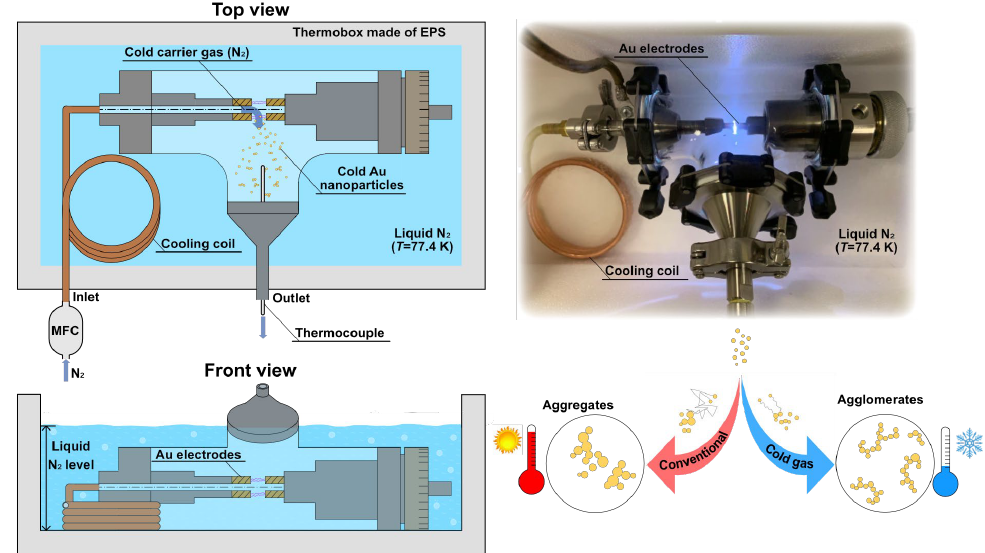
Figure 1. Image of the experimental setup for the synthesis of nano particles in cold gases (N₂, Ar + H₂ , and He) by spark discharge using a sealed gas-discharge chamber immersed in liquid nitrogen ( T = −196 °C).